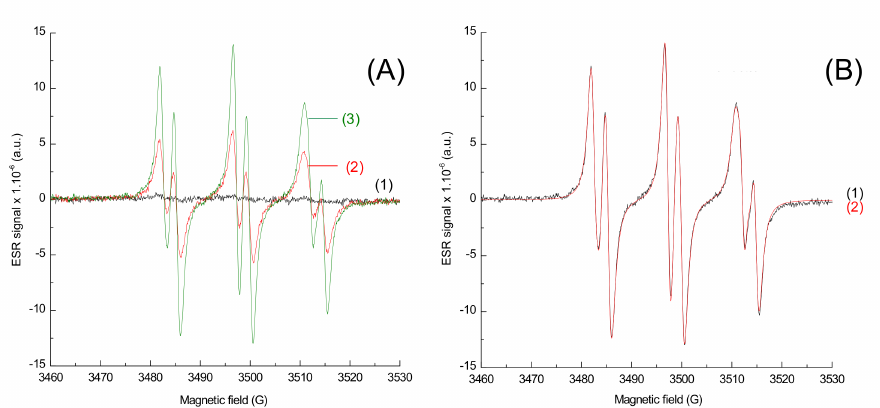
Figure 9. ESR-Spin trapping spectrum of Napht-B1 in combination with Ar 2 I + PF 6 − and 4-dppba in acetonitrile; under air; phenyl- N-tert -butylnitrone (PBN) is used as a spin trap. ( A ) Experimental spectrum (1) before irradiation; after (2) 40 s and (3) 80 s of irradiation with LED@405 nm (I ≈ 110 mW · cm − 2 ) exposure; ( B ) after 80 s of irradiation with LED@405 nm (I ≈ 110 mW · cm − 2 ) exposure (1) experimental and (2) simulated with the hyperfine coupling constants hfc (a N = 14.2 G; a H = 2.2